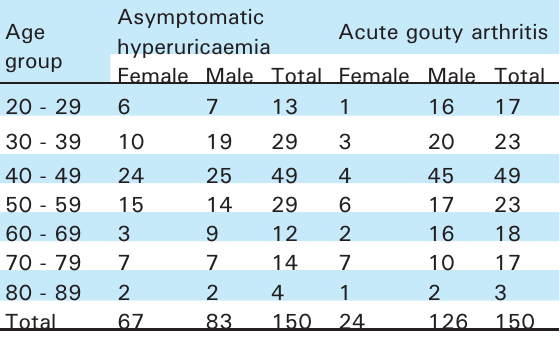
Table 1: Age distribution of the